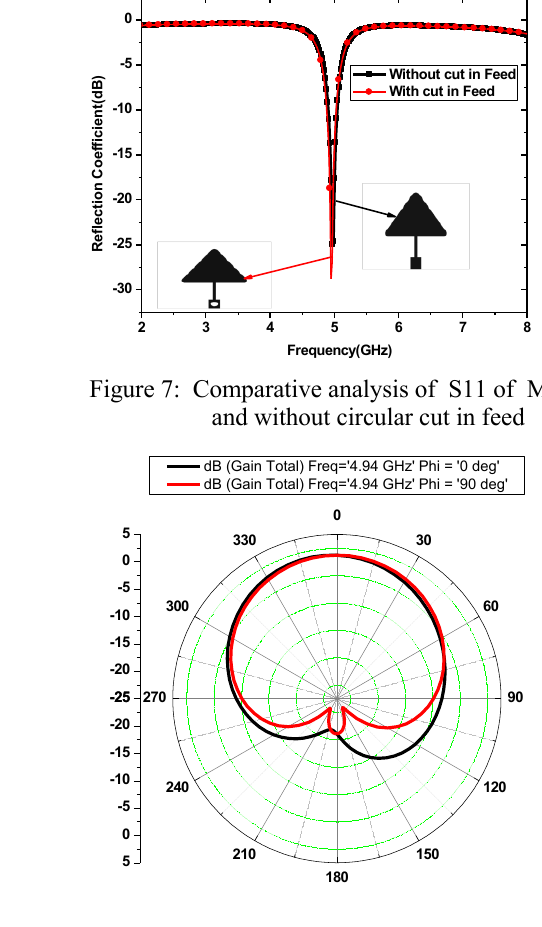
Figure 8: Radiation pattern of MTPA at 4.94 GHz